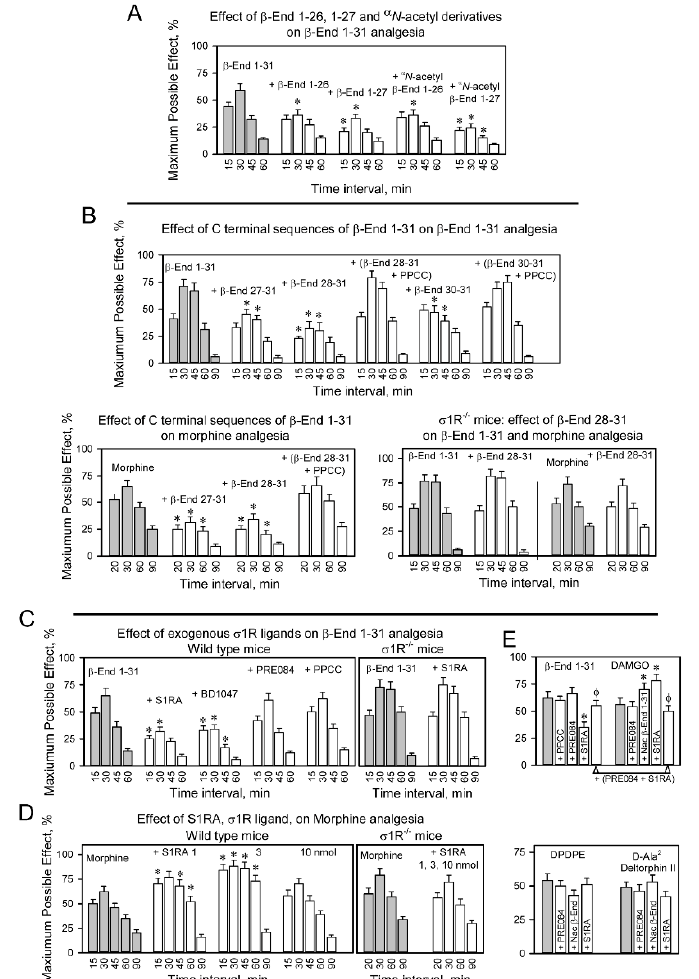
Figure 3. Effect of physiological β‐ End 1–31 derivatives on morphine and β‐ End 1–31